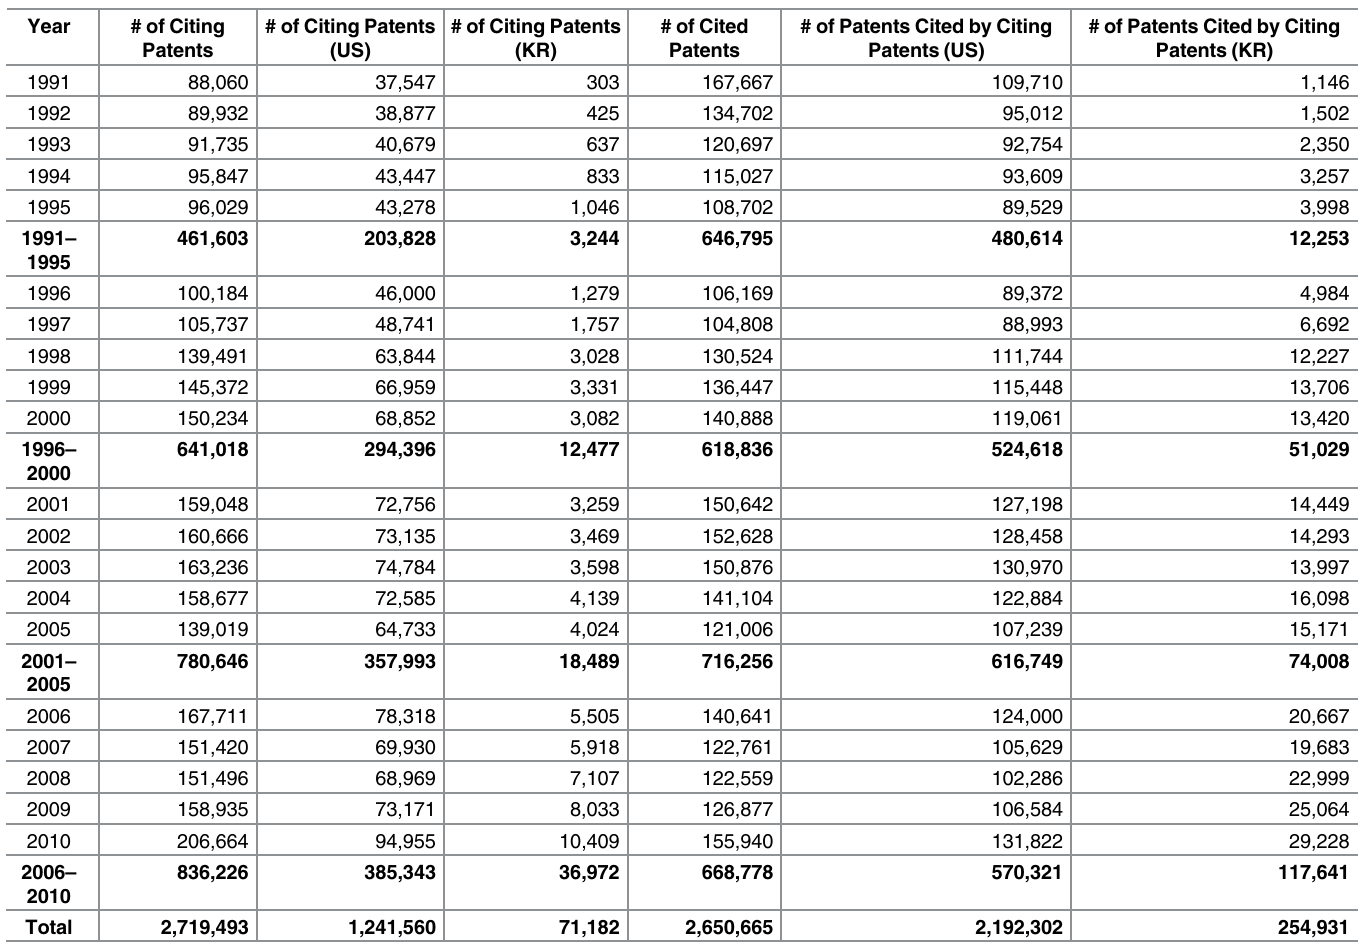
Table 5. Basic Information from Patent Citation Dataset.